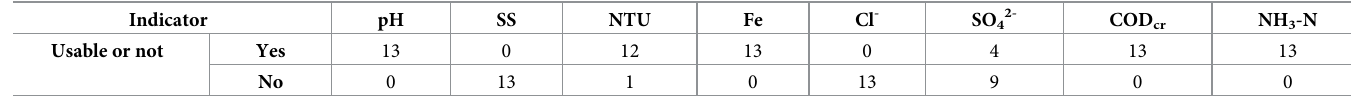
Table 7. Environmental quality of 13 surface water samples from the salt marsh area for industrial uses. Indicator Usable or not